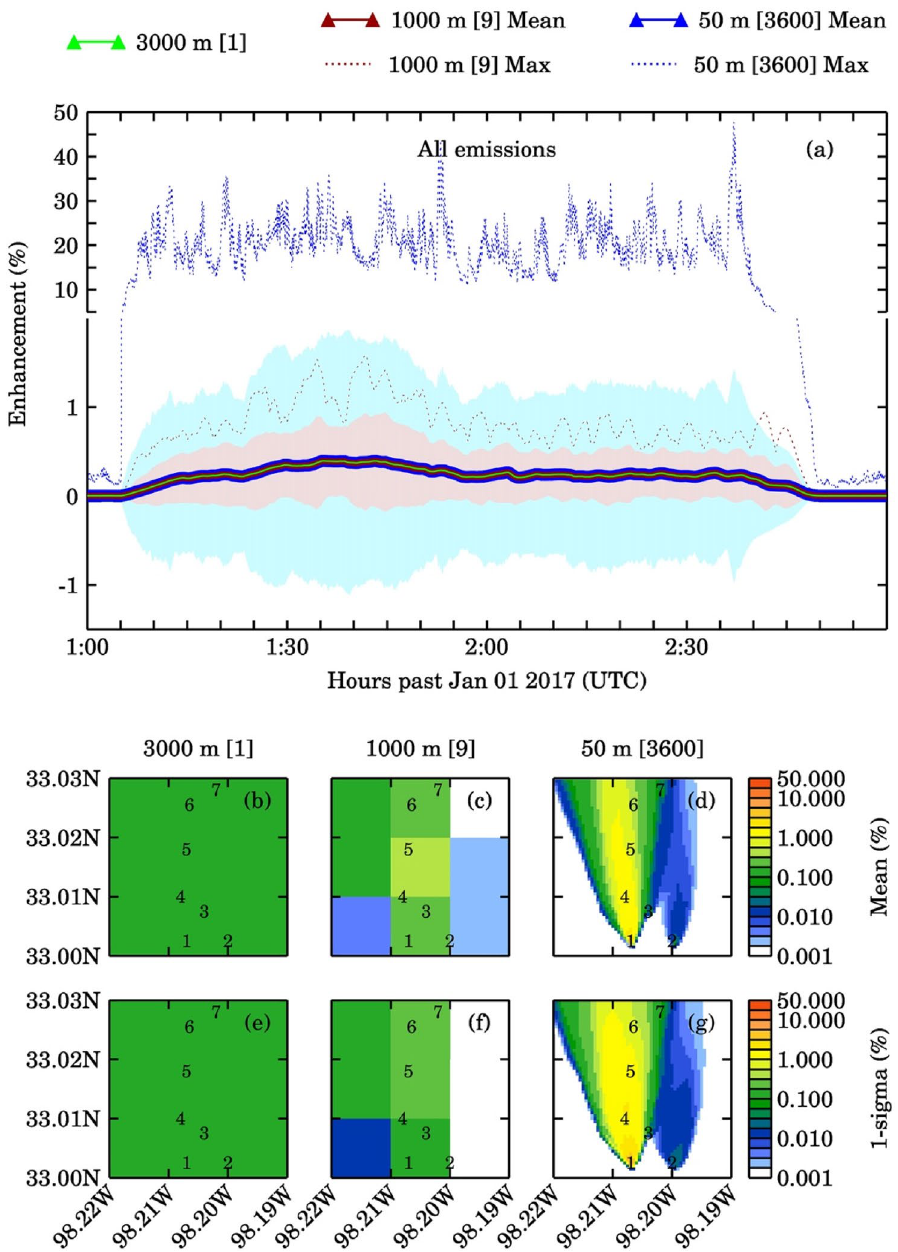
Figure 2. ( a ) Time series of percentage methane column enhancement with all emissions sources during the two-hour simulation period for three pseudo satellite pixels (there are 3600, 50 m pixels; 9, 1000 m pixels in one 3000 m pixel). Light green, dark red, and dark blue solid lines represent mean values and dotted lines represent maximum values over 3000 m, 1000 m and 50 m pixels, respectively. The plot also shows 1-sigma standard deviation as shaded area (light brown for 1000 m and light blue for 50 m pixels). Plots ( b – d ) represent the temporal averaged spatial distribution of column enhancements for three satellite pixels and plots ( e – g ) represent the 1-sigma variations to the mean column enhancements. The numbers mentioned in the square brackets are the number of pixels for each